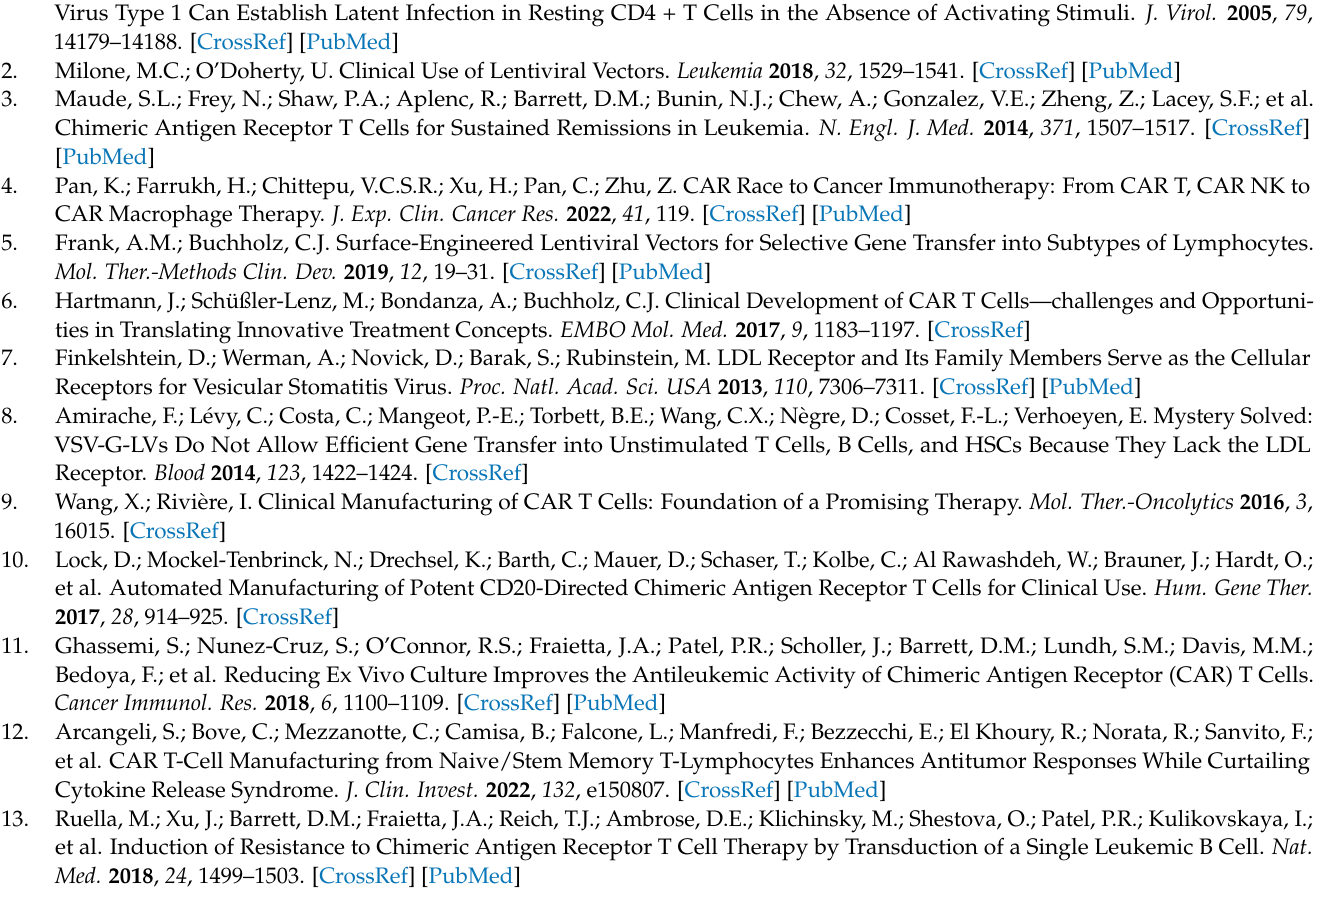
LVs; Figure S2: Evaluation of transduction enhancers; Figure S3: Stability of gene transfer; Figure S4: Production of CAR-T cells using the CD20-CAR-encoding